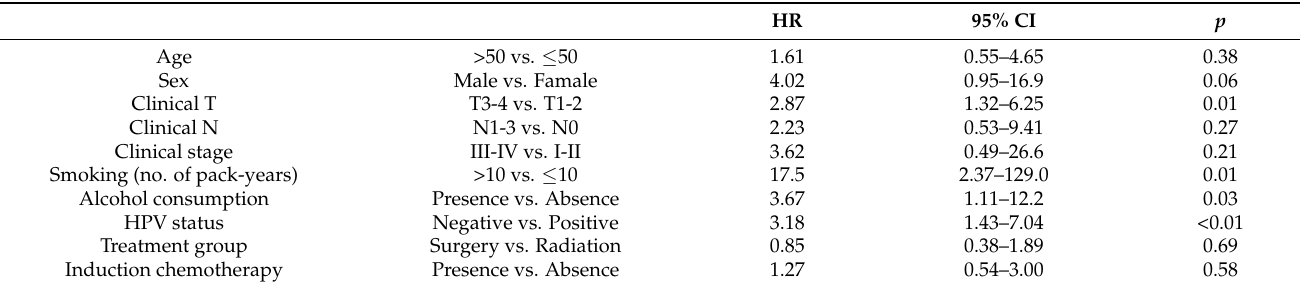
Table 4. The univariate analysis of factors associated with OS.